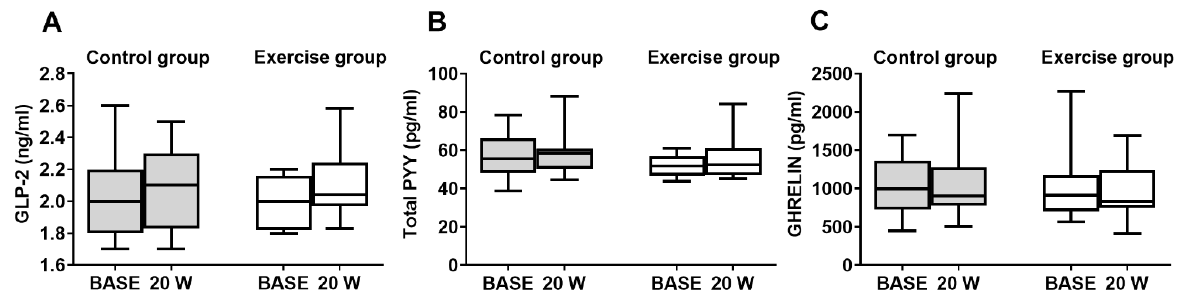
Figure 3. Endogenous gut peptide levels measured at baseline (BASE) and after 20 weeks (W20) in the control group and exercise group. ( A ) Box and whisker plot of GLP-2. ( B ) Box and whisker plot of PYY. ( C ) Box and whisker plot of